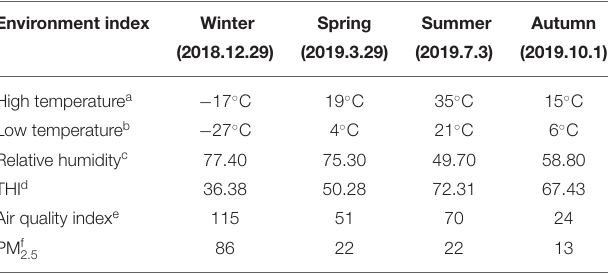
TABLE 1 | Environmental index of the day at different sampling time points. Environment